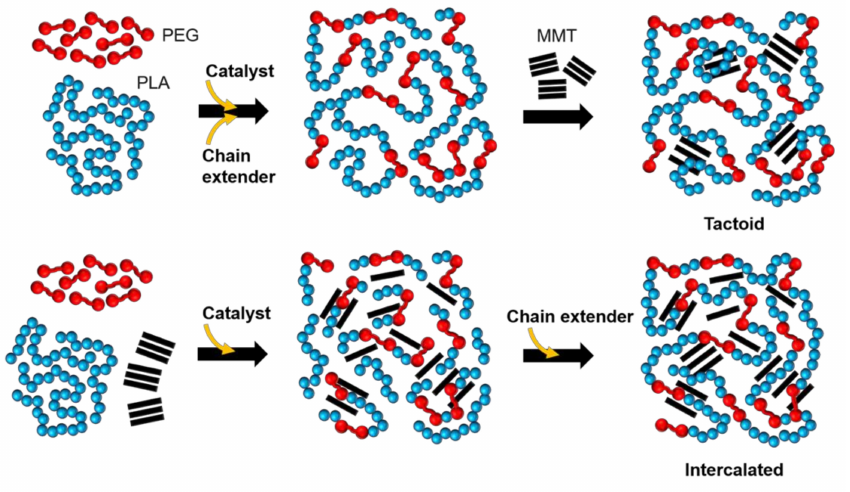
Figure 4. Schematic illustration of melt-copolymerization and nanocomposite